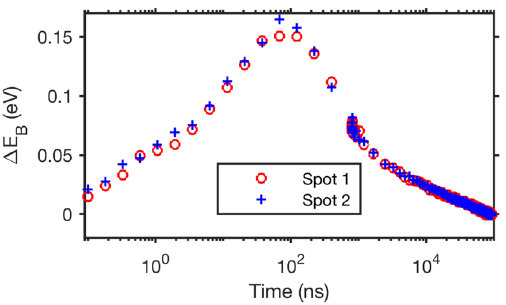
Figure 8. Comparison of averaged delay scans from Fig. 7 measured in two different sample spots with a laser pulse energy of 15.4 nJ on a 250 nm thick PbS quantum dot sample. The fit parameters from the different trigger time maps were averaged from the 3rd X-ray pulse after the laser pulse onwards (approximtely from 1600 ns).